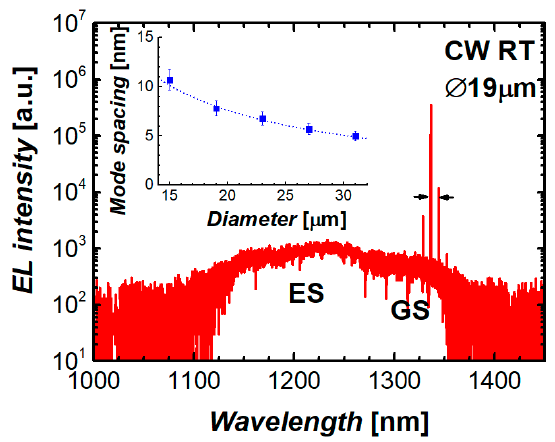
Figure 5. Representative emission spectrum of 19-µm microdisk laser (inset: mode interval vs microdisk diameter, dotted line: ~1/ D ).